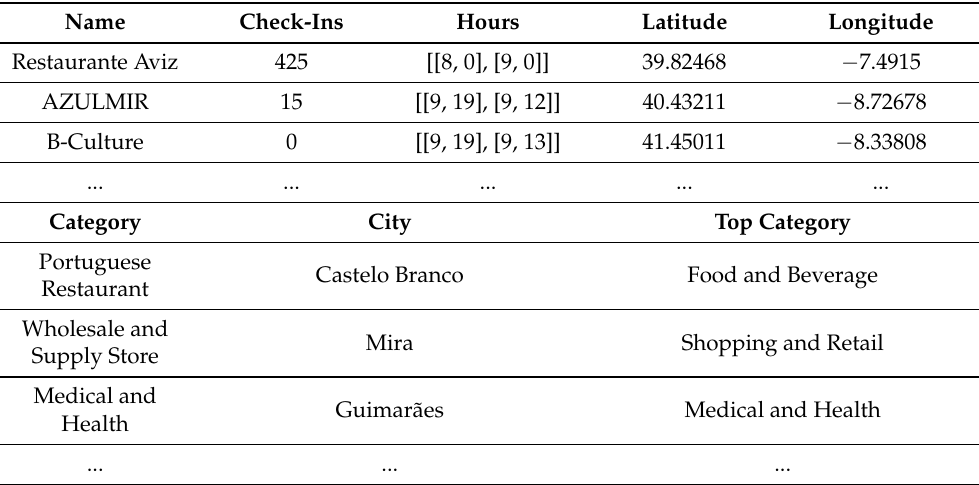
Table 3. Sample of the Facebook Places POI